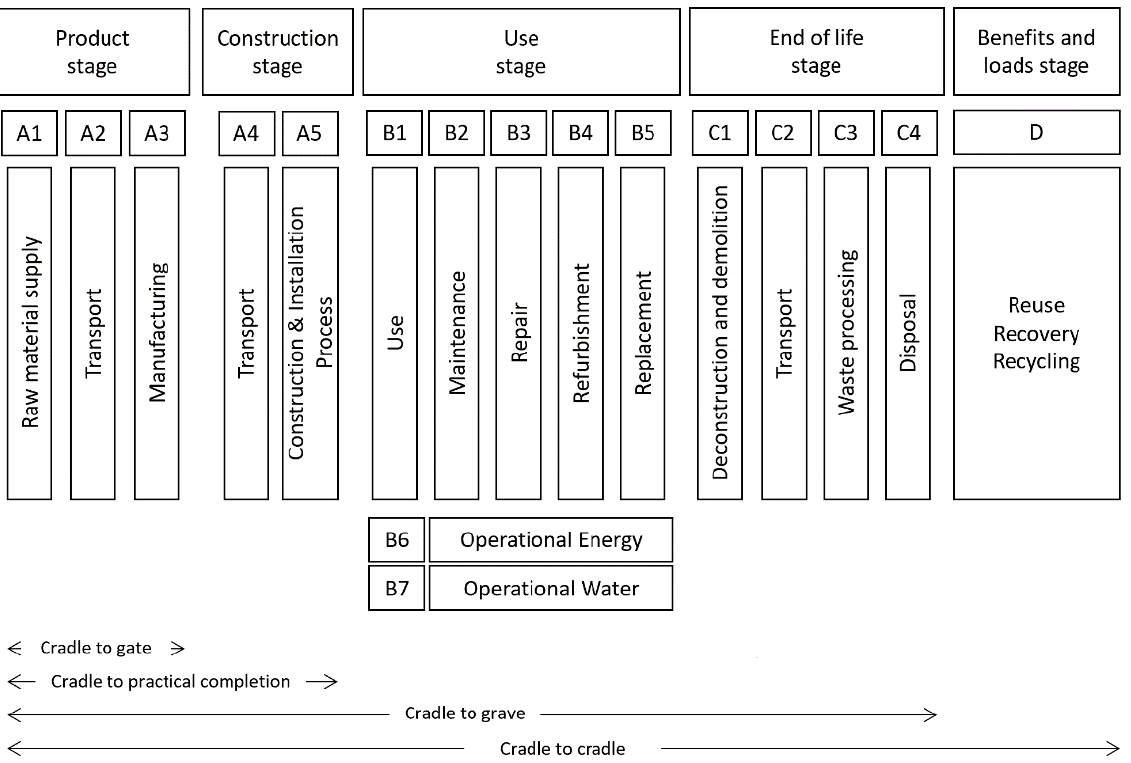
Figure 2. Module framework for life cycle stages of buildings.